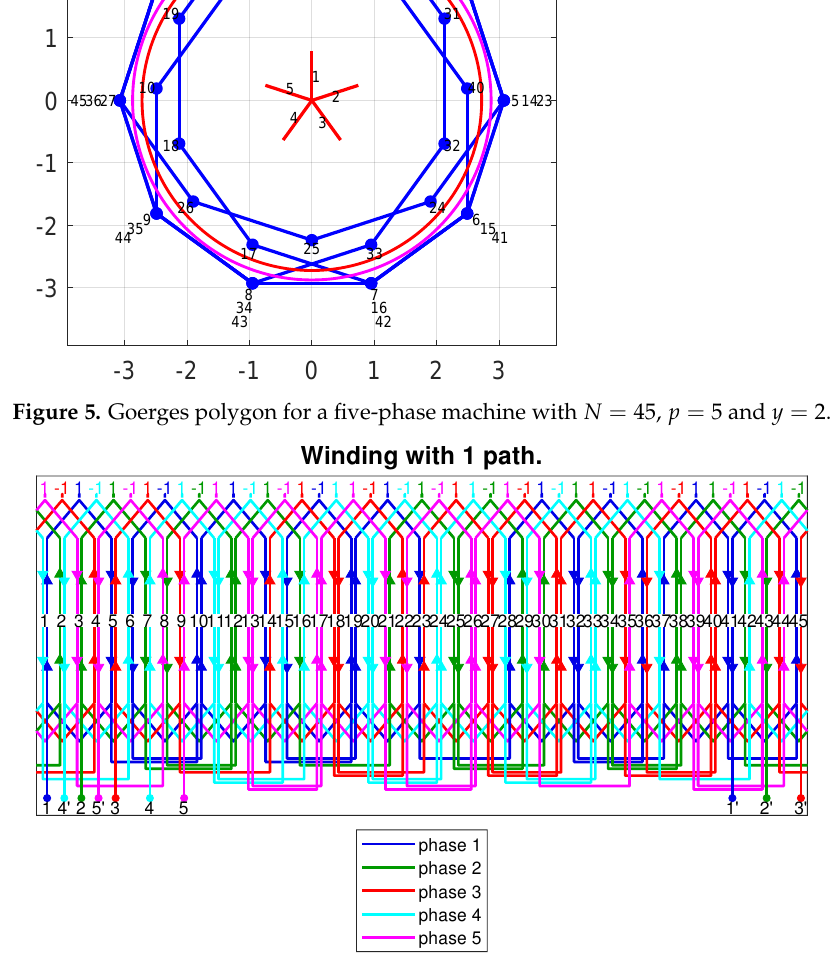
Figure 6. Winding scheme for a five-phase machine with N = 45, p = 5 and y =